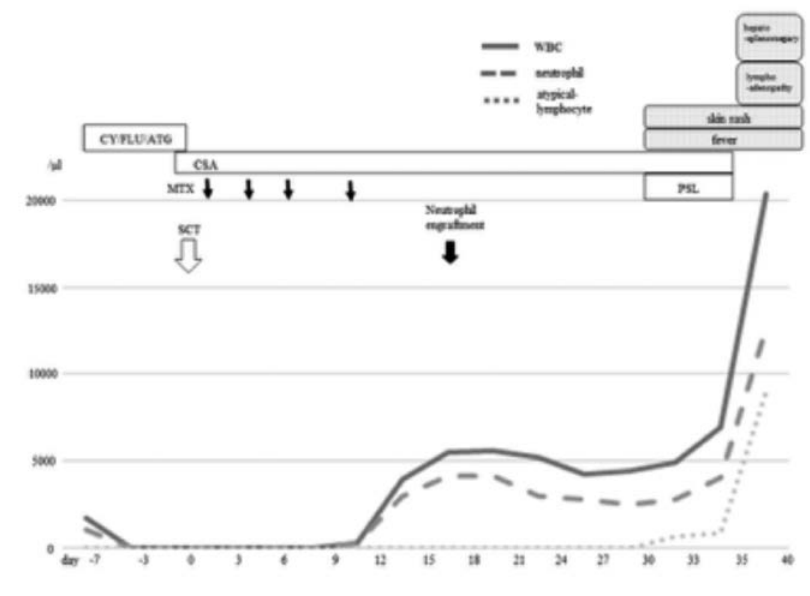
Figure 1. The course of hematopoietic stem cell transplantation. From day 30, he devel- oped high-grade fever and grade 2 skin GVHD, and abnormal lymphocytes appeared in the peripheral blood examination. On day 35, he developed sudden hepatomegaly and cervical lymphadenopathy, and he died on day 40. CY: cyclophosphamide; FLU: fludara- bine; ATG: antithymocyte globulin; CSA: cyclosporine; MTX: methotrexate; SCT: stem cell transplantation; PSL: prednisolone; WBC: white cell